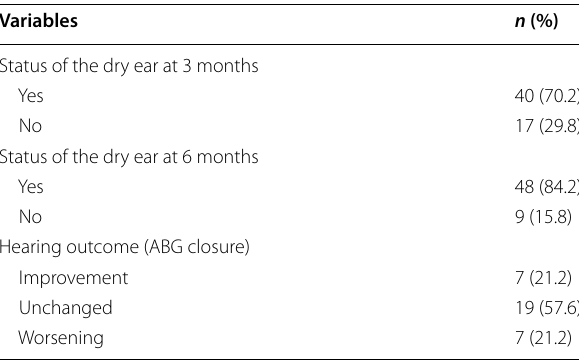
Table 3 Postoperative outcome of the